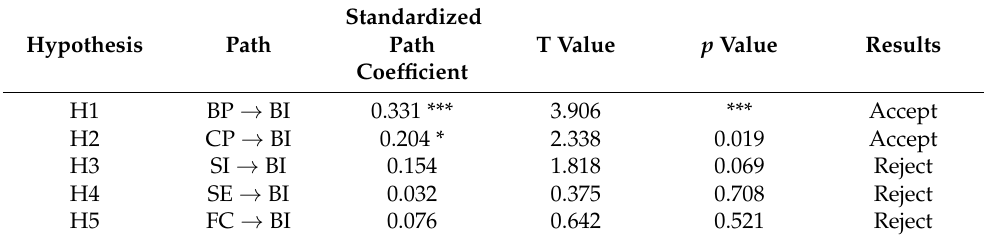
Table 8. Standardized path coefficient and hypothesis test of structural equation model. Hypothesis Path